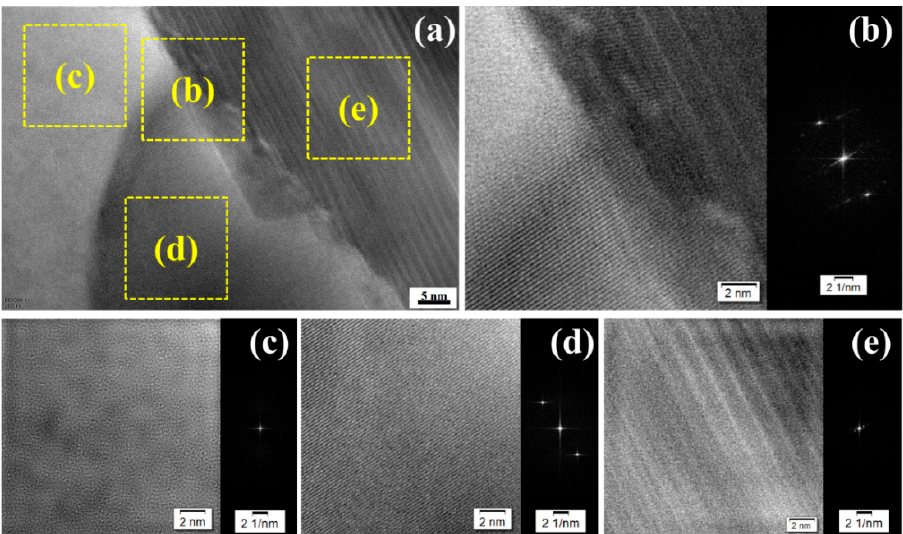
Figure 6. High-resolution transmission electron microscopy (HRTEM) images of the SiC/Al boundary in the TLSPed-30 J specimen. ( a ) Full-scale view of the SiC/Al boundary, ( b ) inverse fast Fourier transform (IFFT) image taken from the square (b) showing a metallurgical combining interface, ( c ) IFFT image taken from the square (c) showing the enlarged view of amorphous structure, ( d ) IFFT image taken from the square (d) showing the enlarged view of uniform atom layer in the aluminum substrate and ( e ) IFFT image taken from the square (e) showing stacking faults inside the SiC particle.